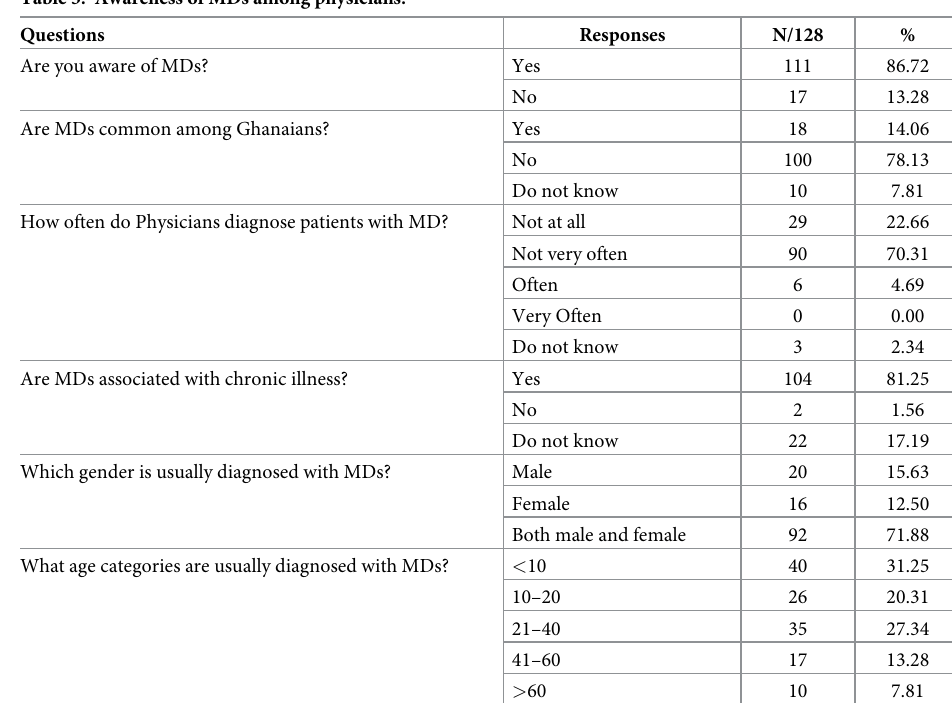
Table 3. Awareness of MDs among physicians.